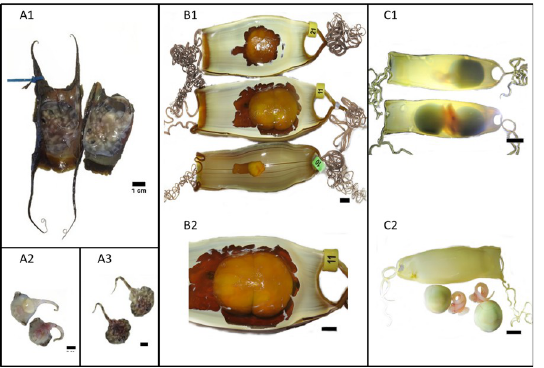
Fig 1. (A1) Two R . undulata juveniles in one, splayed open, egg case. (A2) The ventral surface and (A3) the dorsal surface of the two R . undulata twins. (B1) The S . stellaris twin egg case (middle) next to its paired-egg case and another egg (bottom). (B2) Closer view of the twined egg case. (C1) S . canicula twin embryos (bottom) next to a non-twin sibling (top). (C2) S . canicula twins after removal from their egg case. The black scale bars are 1cm in